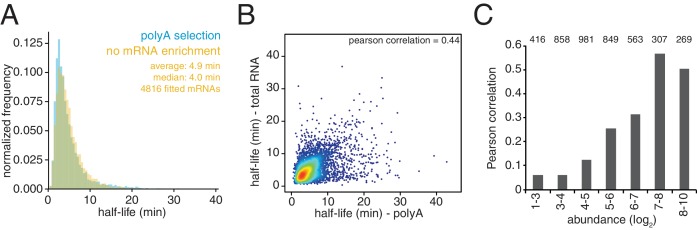
Comparison of mRNA stabilities in the presence or absence of mRNA enrichment.(A) The experiment described in Figure 1C was performed in the absence of oligo-dT selection (no mRNA enrichment). Half-lives are plotted by frequency against the data derived from the experiment in Figure 1C (polyA selection) and the width of each bin is 0.5 min. (B) Scatter plot of half-life values from (A) and Figure 1C. Colors represent density of datapoints as in Figure 1—figure supplement 1C. (C) Data were binned by abundance and the pearson correlation for each of these subgroups between the data from A and Figure 1C is plotted. The population of each bin is indicated by the number above each bar.10.7554/eLife.32536.007Figure 1—figure supplement 2—source data 1.Source data for Figure 1—figure supplement 2A–B: transcriptome wide decay data prepared without polyA selection.